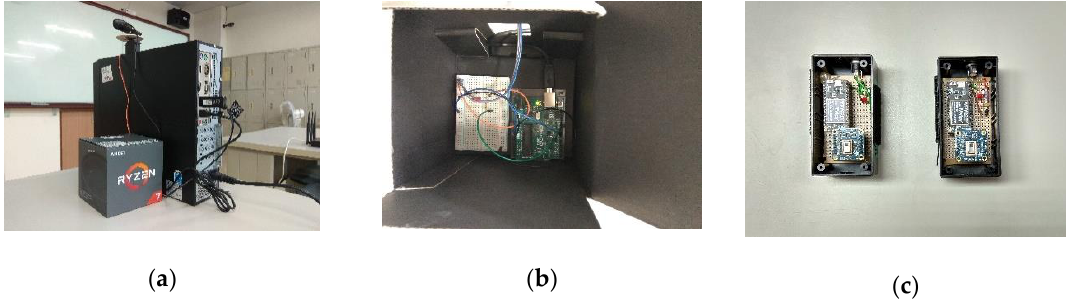
Figure 7. Devices used in experiments: ( a ) Computer placed in the first row; ( b ) Arduino UNO WiFi connected with the computer; ( c ) AMG8833 integrated with WiPy 3.0. Table 2. Hardware and software platforms used in the intelligent lecturer tracking and capturing (ILTC) system.